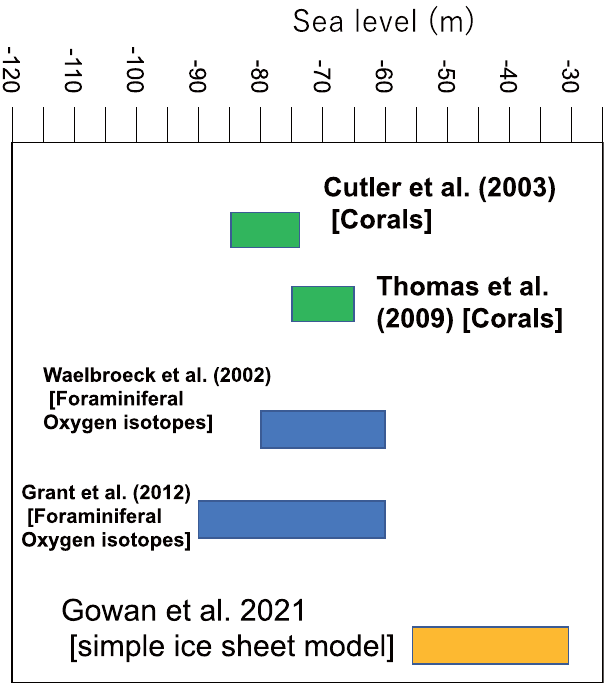
Fig. 2 | Comparisonbetween recentlypublished MIS3 (Marine Isotope Stage 3) sea level model results, reported by Gowan et al. (EJG21) 1 and previous actual measurements 6,7,12,15 . There is a clear discrepancy between the two that